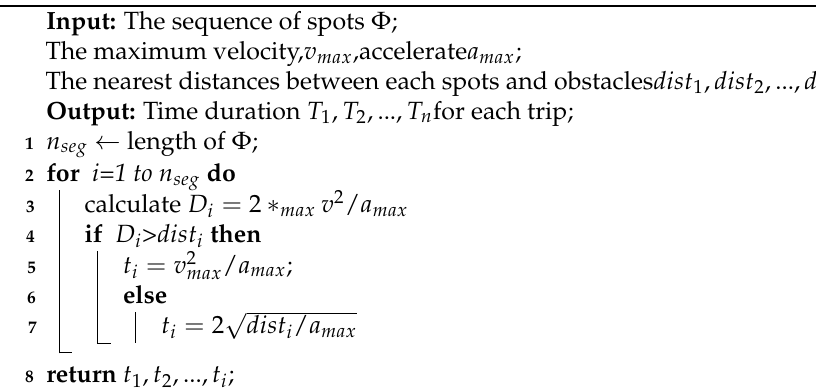
Algorithm 5: Arbitrary time duration t 1 , t 2 , ..., t n for HUAV to travel through